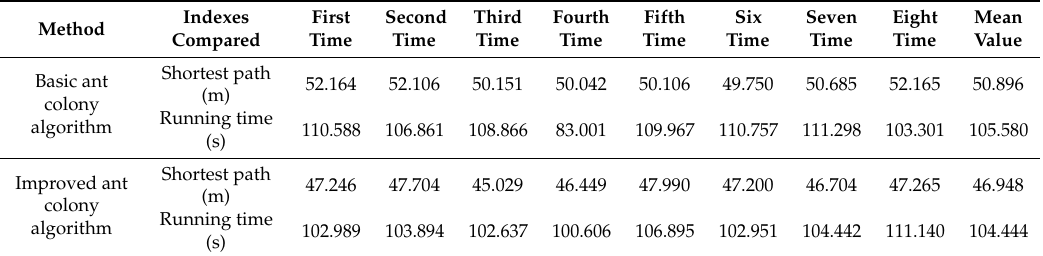
Table 2. The running data of the first terrain.